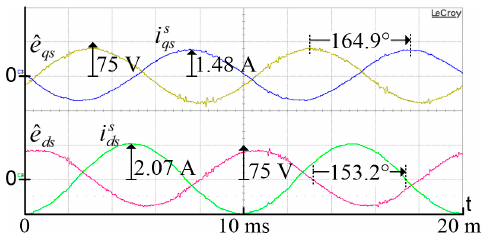
Figure 11. Measured steady-state currents and estimated back-EMF when the current controllers were activated without speed and position feedback and with no decoupling voltage. Table 1. Comparison of the measured and calculated currents at various speeds.